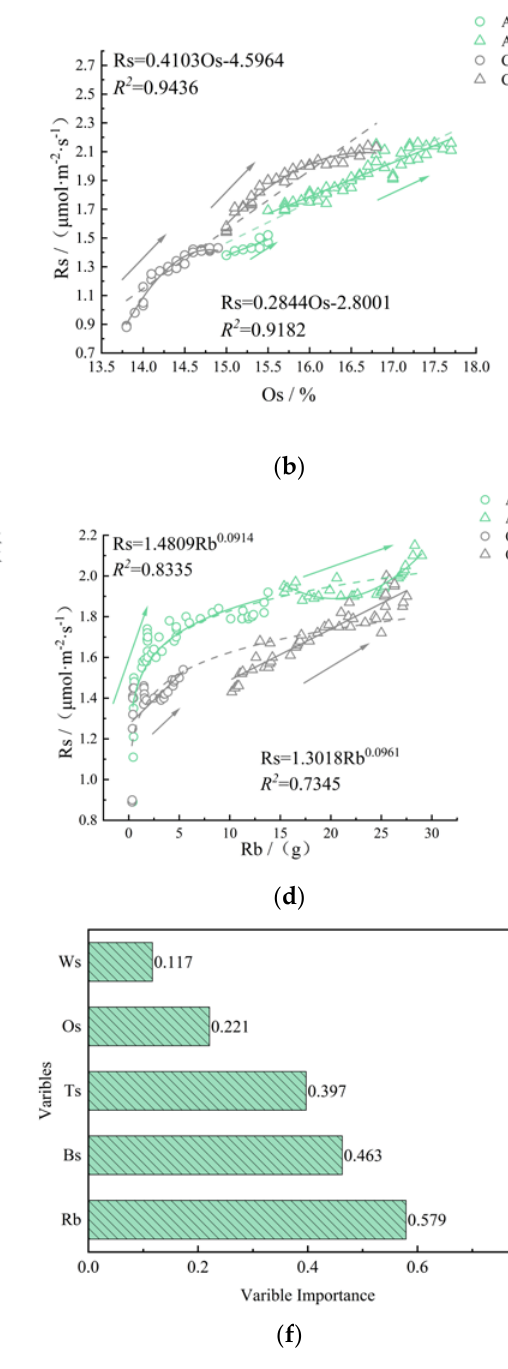
Figure 8. Relationships between soil respiration rate and soil temperature ( a ), soil oxygen content ( b ), soil water content ( c ), root biomass ( d ), and soil bacterial biomass ( e ), under AI and CK condi- tions and importance of variables of the RF model for soil respiration rate ( f ), projection of im- portance of variables affecting soil respiration rate (VIP) (AI, aerated irrigation; CK, unaerated sub- surface drip